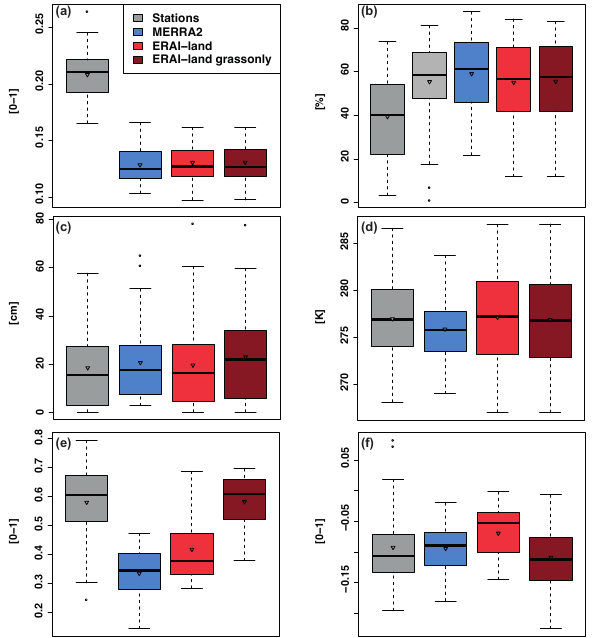
Figure 5. Box plot analysis for MAMJ 2000–2013: (a) snow free albedo, (b) snow cover fraction, where the light grey box plot is the originally observed snow cover from stations, (c) snow depth, (d) 2m temperature, (e) mean albedo and (f) snow albedo change within the season. Triangle indicates the mean value.